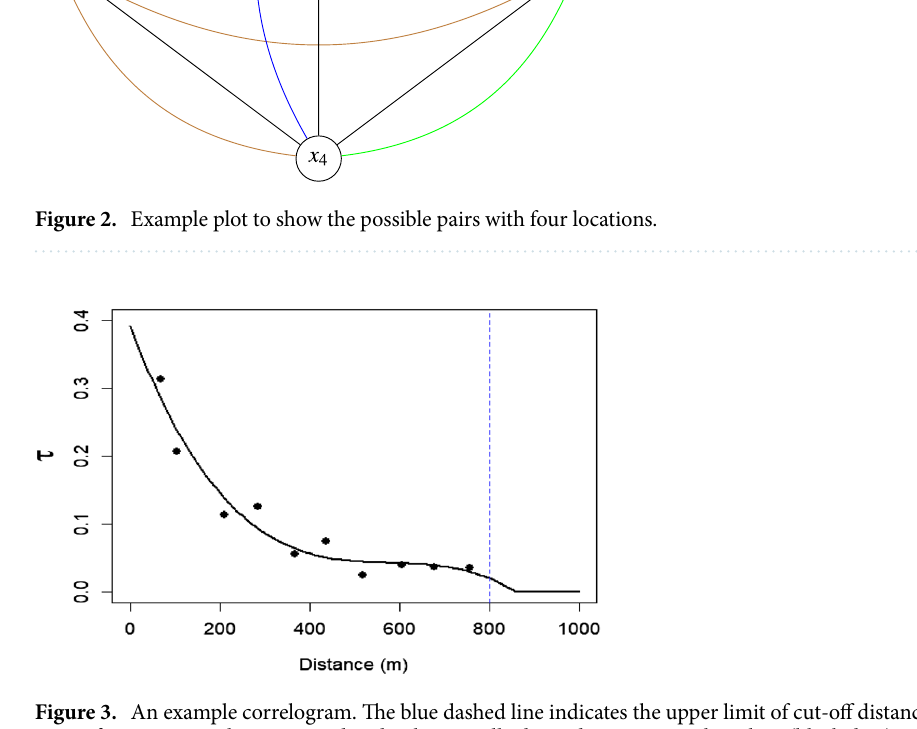
Figure 3. An example correlogram. The blue dashed line indicates the upper limit of cut-off distance at which pairs of points are no longer considered to be spatially dependent. Empirical τ values (black dots) overlaid with theoretical cubic smooth